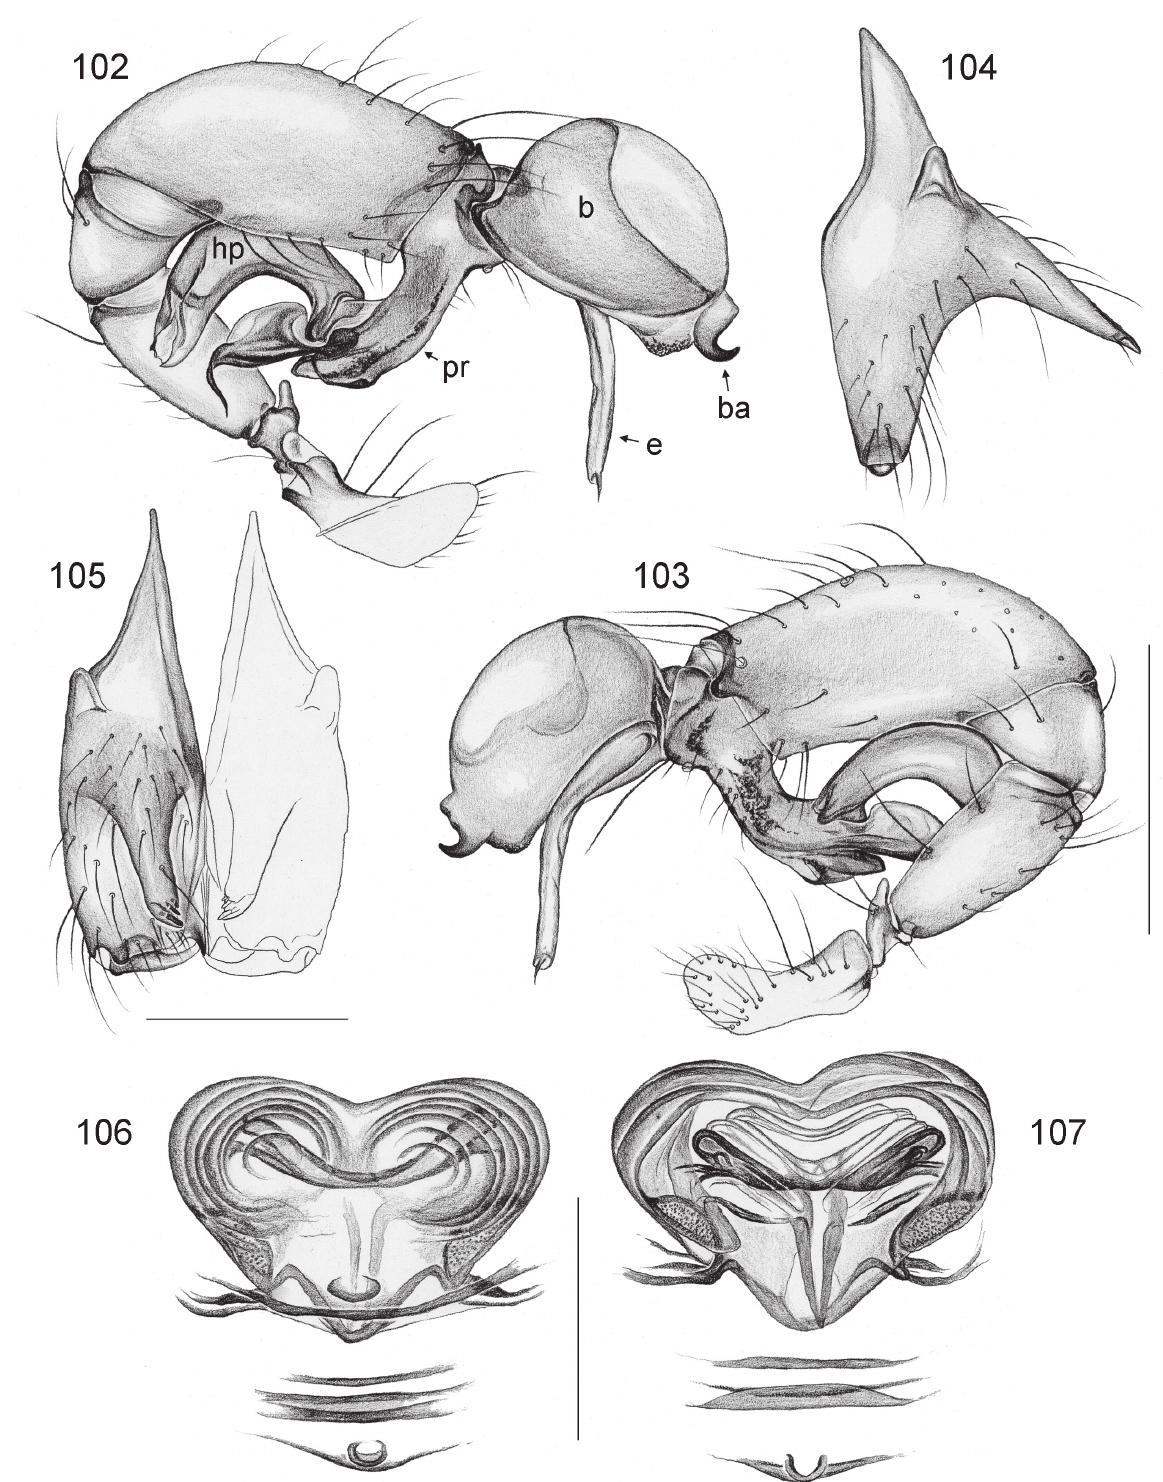
Figs 102-107. Spermophora awalai sp. nov. 102-103 . Left ♂ palp, prolateral and retrolateral views. 104- 105 . ♂ chelicerae, lateral and frontal views. 106-107 . Cleared ♀ genitalia, ventral and dorsal views. b = bulb; ba = bulbal apophysis; e = embolus; hp = hinged process; pr = procursus. Scale lines: 102-103 = 0.5 mm; 104-105 = 0.2 mm; 106-107 = 0.3